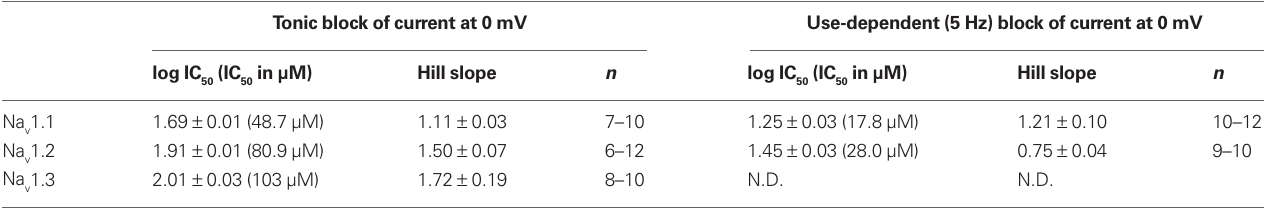
Table 4 | Tonic and use-dependent block of brain voltage-gated sodium channels by r-( +